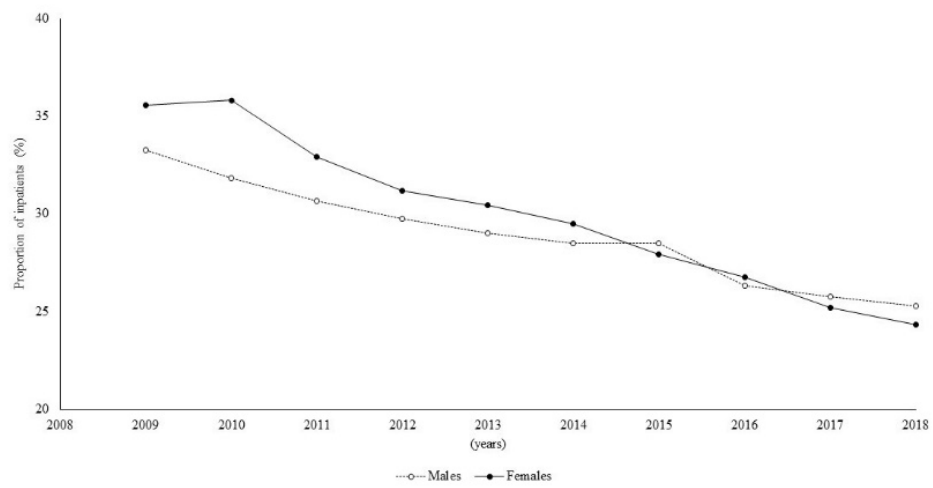
Figure 3. Time trend of proportion of inpatients by sex. In particular, a significantly higher percentage of females among the inpatients was observed for the first three years of the study period ( p < 0.05), while, subsequently, no significant differences were